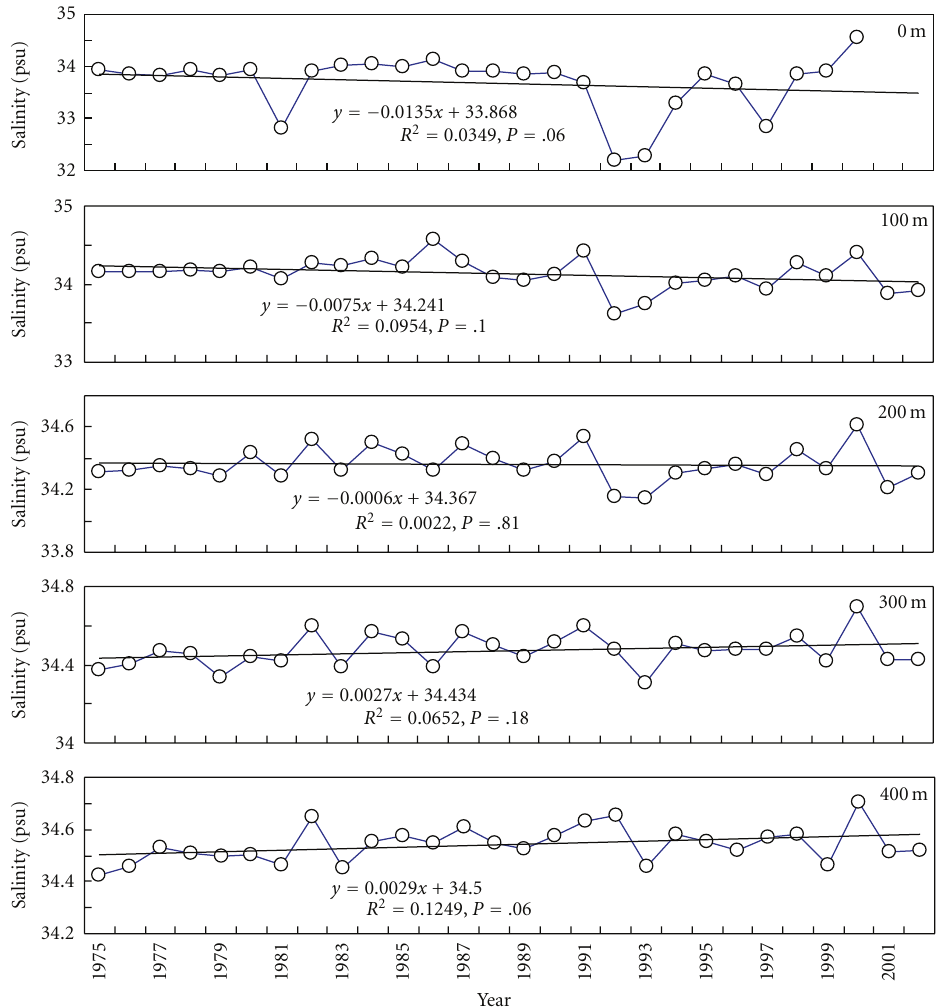
Figure 6: Long-term time series of the mean sea water salinity at the surface, 100 m, 200 m, 300 m, and 400 m during austral summer (January–March) between 1975 and 2002. Solid lines represent linear